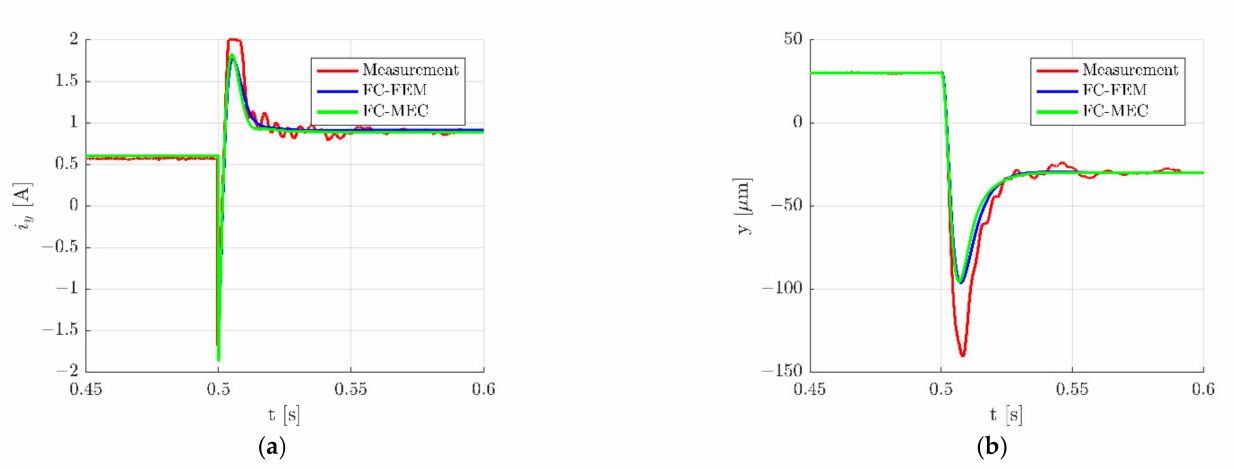
Figure 13. Zoom of time responses of the control current i y ( a ) and the rotor position y ( b ) for the step change ± 30 µ m along the y